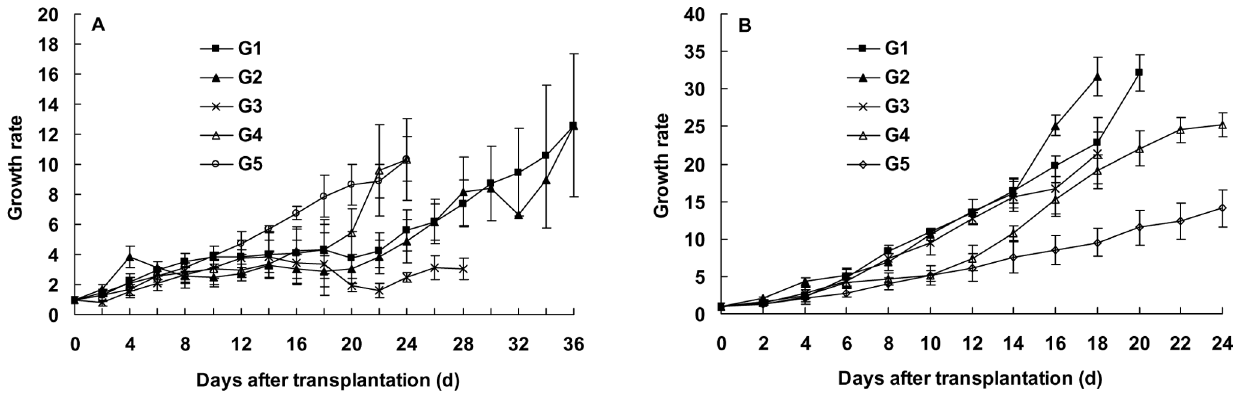
Figure 6. Growth rates of the cucurbits-specialized aphids on cotton (A) and on cucumber (B). The transferred aphids were reared for 1–5 generations (G1–G5) on cowpea. Bars are means 6 1SE.